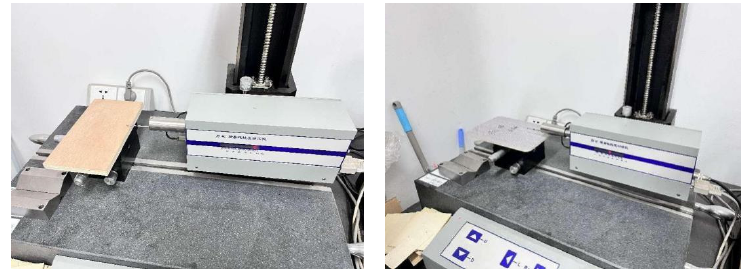
Figure 2. Material surface roughness test.